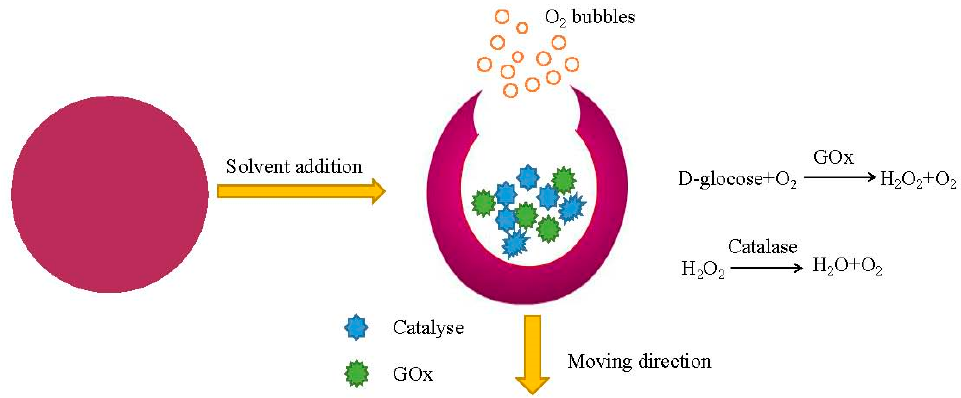
Figure 5. Supramolecular structure of the enzyme-driven stomatocyte micromotors. The motor is driven by a combination of catalyse and glucose oxidase.